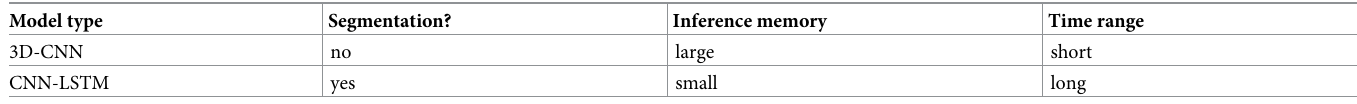
Table 3. Comparison of 3D-CNN and